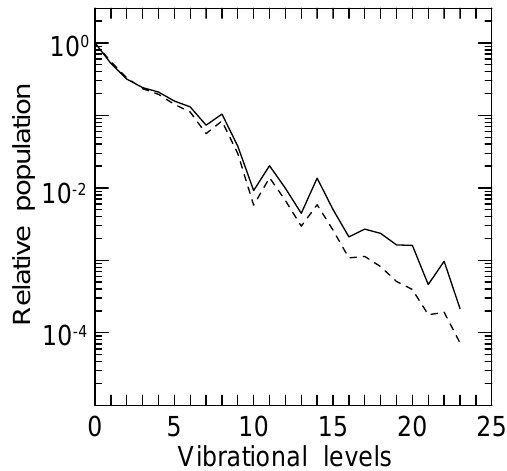
Fig. 10. The calculated relative vibrational populations [N 2 (A 3 6 + u ,v)]/[N 2 (A 3 6 + u , v =0)] at altitudes of 100 and 80km (dashed and solid lines,